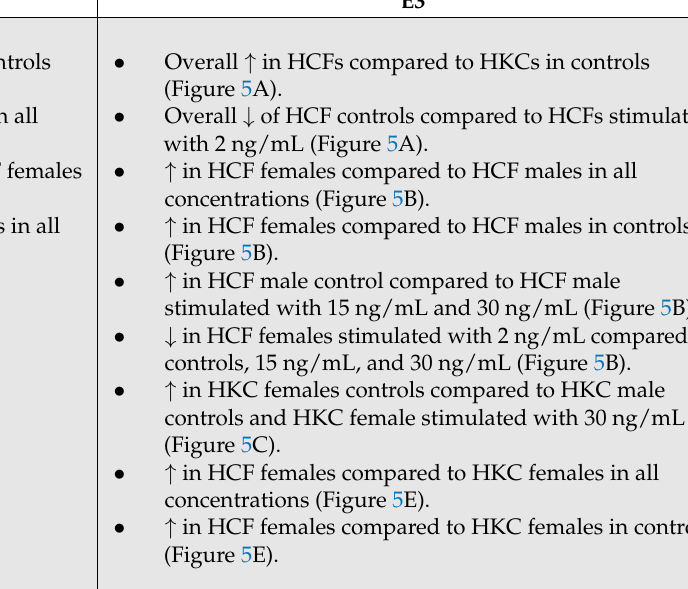
Table 1. Summary for protein expression results of sex hormone receptors in of HCFs and HKCs stimulated with E1 and E3. ↑ = upregulation and ↓ = downregulation. E1